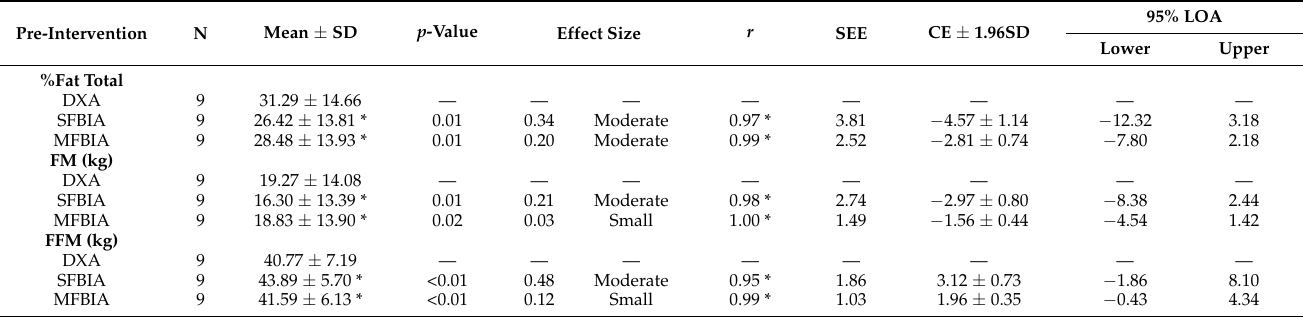
Table 1. Comparison of body composition metrics between DXA and BIA devices pre- and